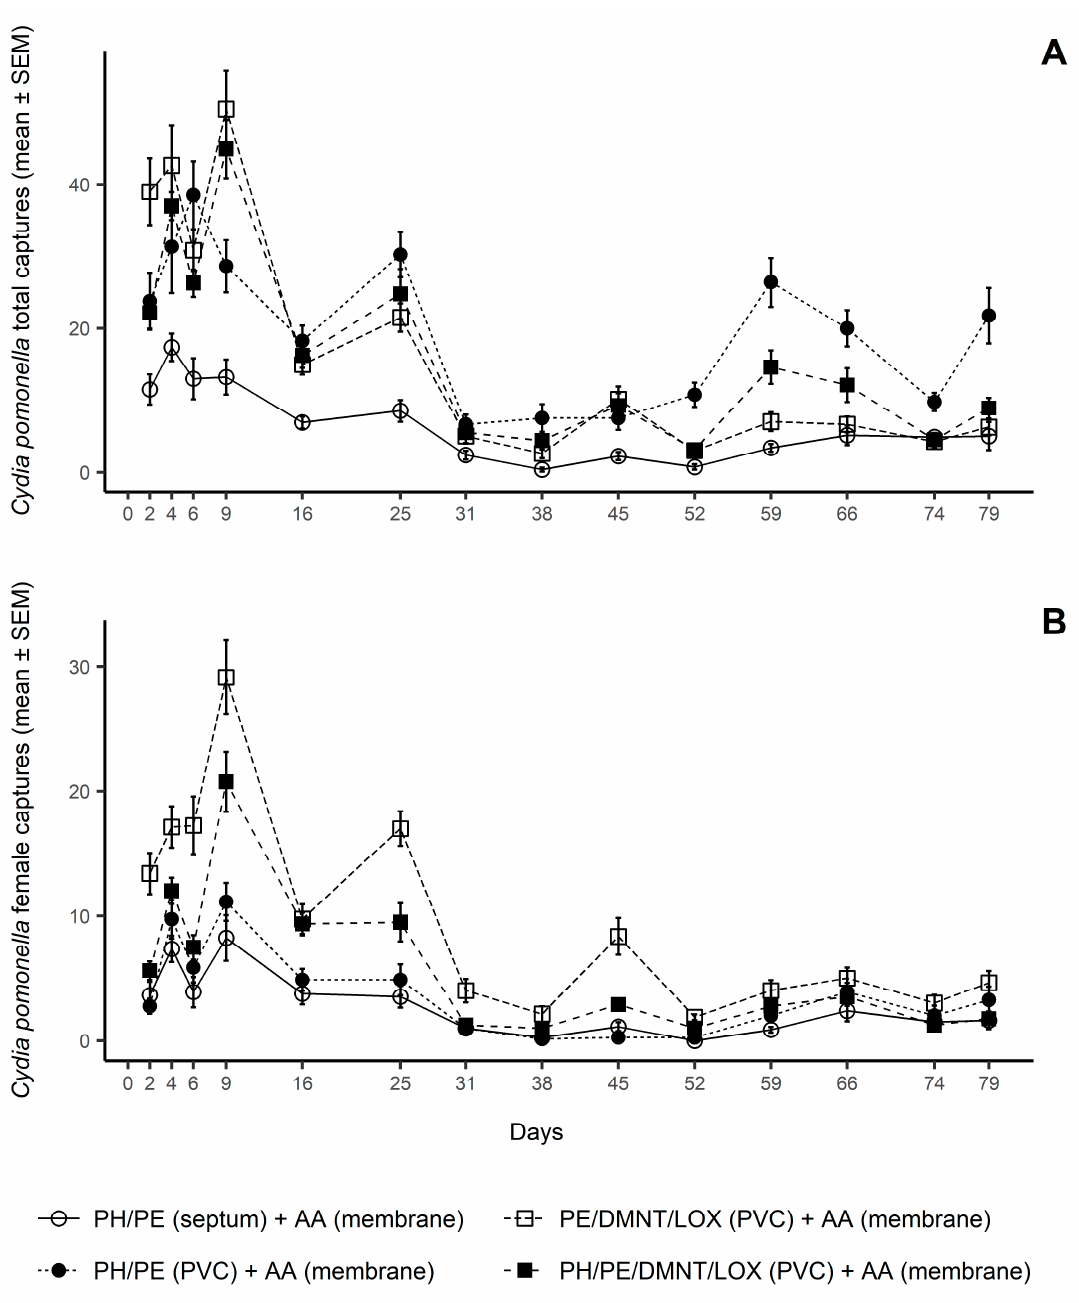
Figure 1. Mean ( ± SEM) codling moth ( Cydia pomonella L.) captures in the weekly trap checks recorded in the USA from 4 May to 22 July 2019. ( A ) = total captures; ( B ) = female captures. This lure longevity study tested four blend combinations of ( E,E )-8,10-dodecadien-1-ol (sex pheromone, PH), ( E,Z )-2,4-ethyl decadienoate (pear ester, PE), acetic acid (AA), ( E )-4,8-dimethyl-1,3,7-nonatriene (DMNT), and linalool oxide pyranoid (LOX), over a 12-week monitoring period (N = 8).